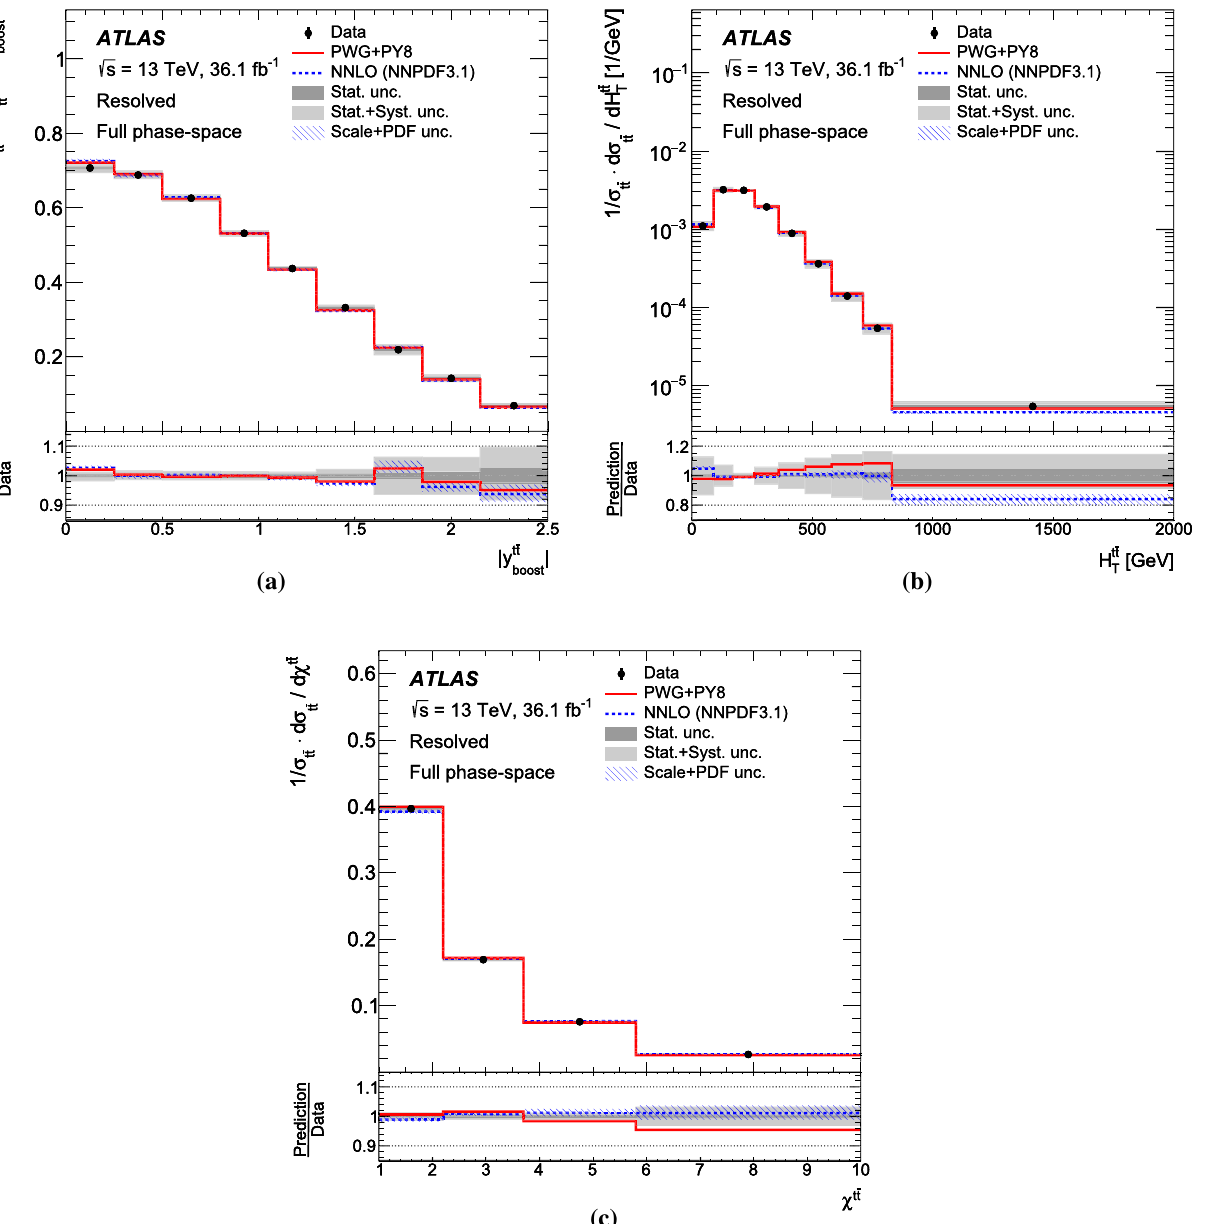
Fig. 57 Parton-level normalised differential cross-sections as a func- | , b H t ¯ t tion of a | y t ¯ t and c χ t ¯ t in the resolved topology, compared boost T with the NNLO predictions obtained using the NNPDF3.1 NNLO PDF set and the predictions obtained with the Powheg + Pythia8 MC gen-